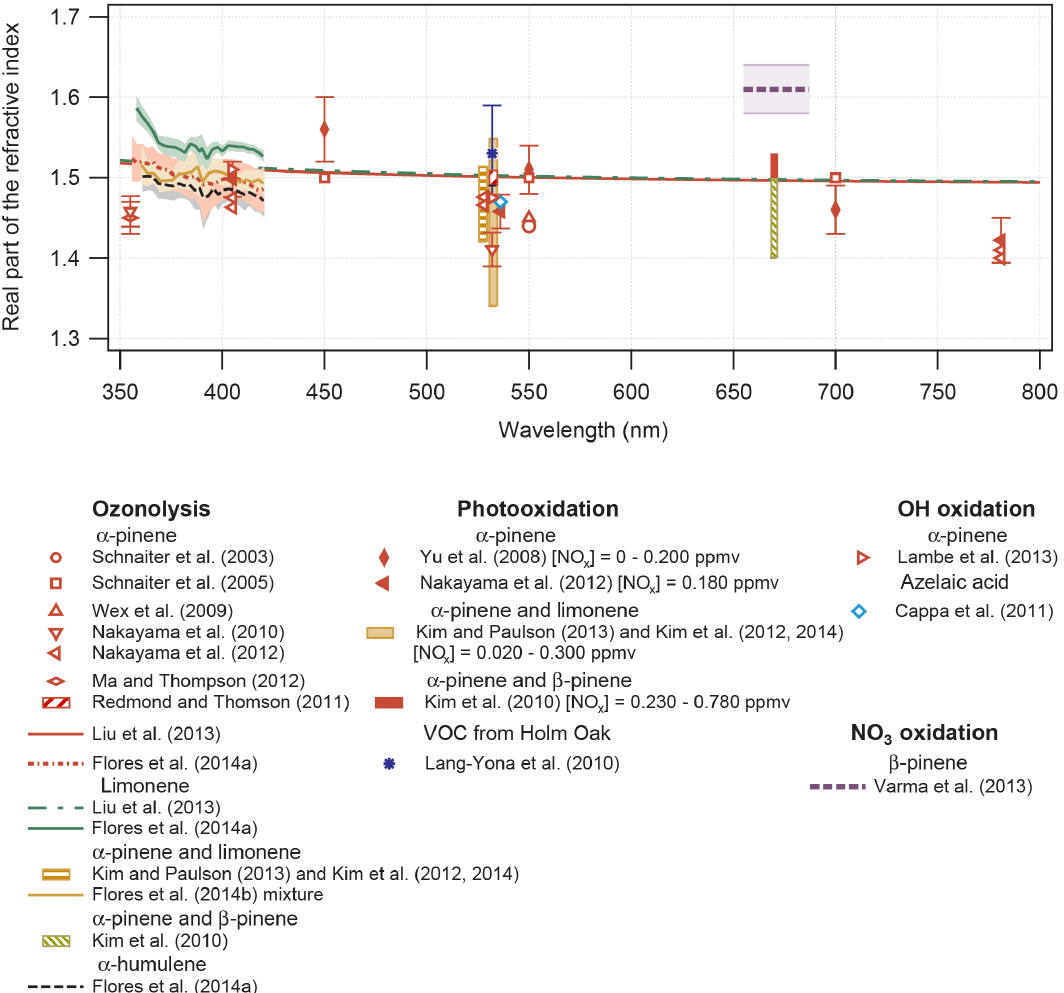
Figure 6. The real part of refractive index (RI) (mr) for biogenic SOA compiled from several chamber studies. The legend specifies the precursor type and oxidation pathway as well as the reference. The figure is reprinted with permission from Moise et al.